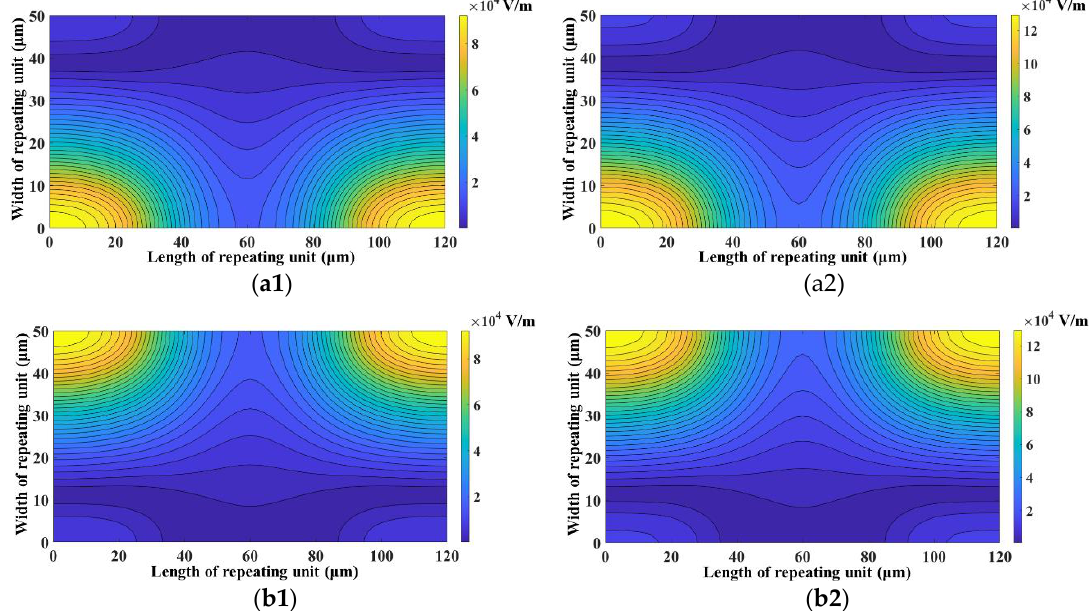
Figure 10. Electric field in the mid-plane along the height of ( a ) focusing section for ( a1 ) w f = 2 µ m and